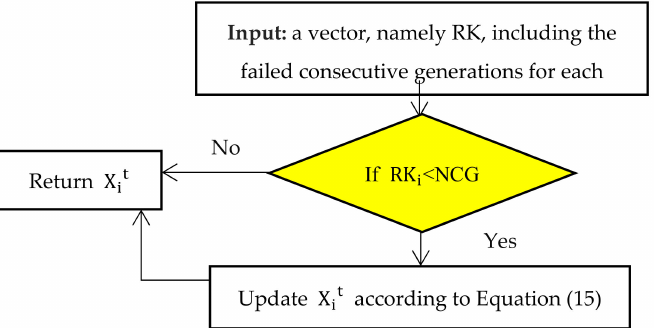
Figure 2. The flow chart of the ranking method integrated with a novel updating